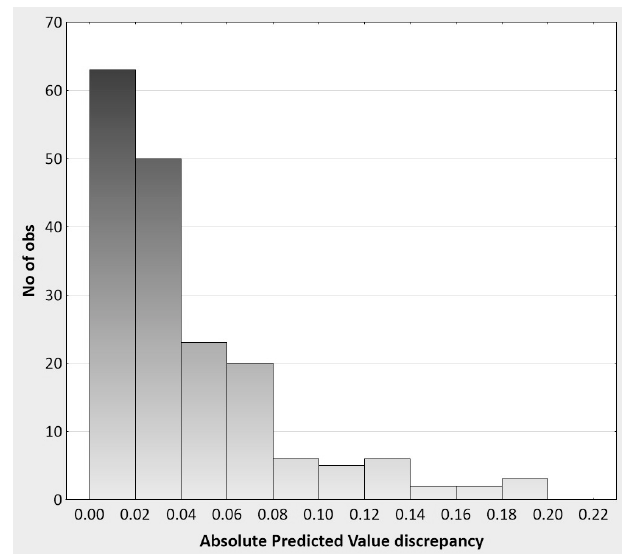
Figure 7. The histogram of absolute value discrepancies between Model 1 and Model 2 predicted observations.